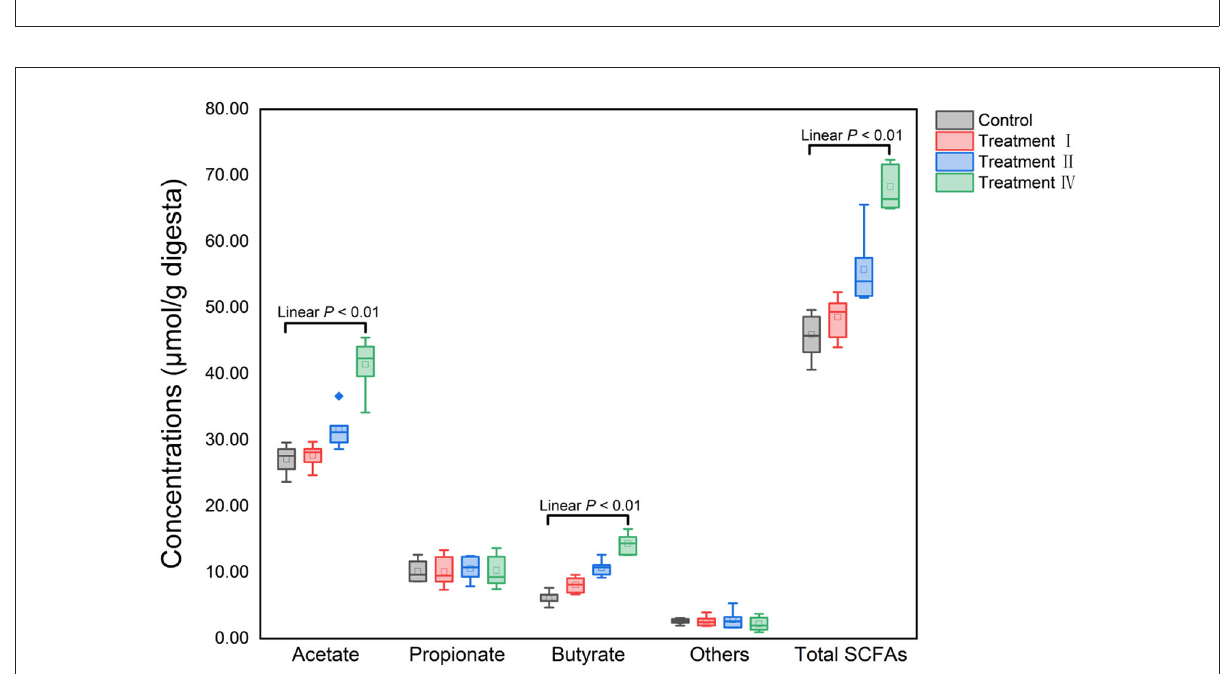
FIGURE7 Variation of fecal SCFAs concentrations among four groups with the increasing of dietary fiber level. Others: isobutyrate, valerate and